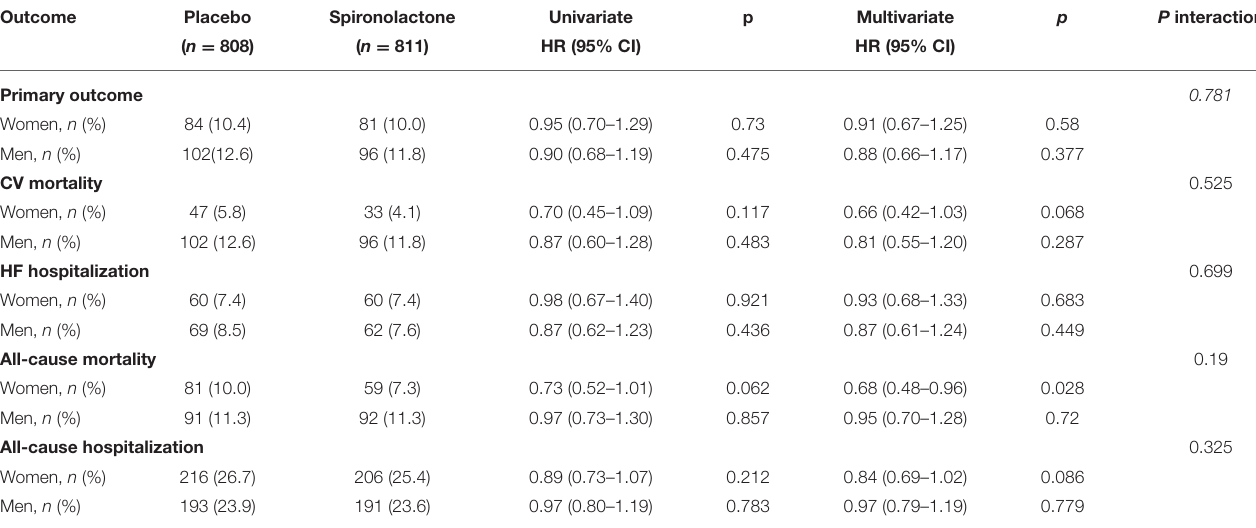
TABLE 3 | Univariate and multivariate hazard ratios and interaction terms between sex and treatment response for all outcomes. Outcome Placebo Spironolactone Univariate p Multivariate p P interaction